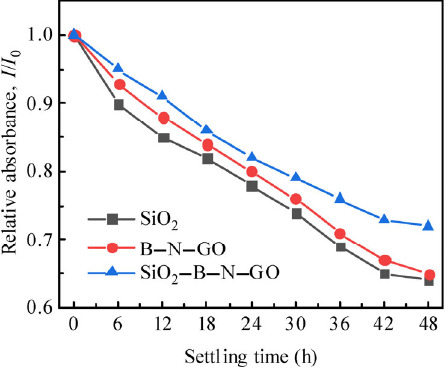
Fig. 4 Dispersion stabilities of the SiO 2 , B–N–GO, and SiO 2 –B– N–GO nanomaterials in the base oil.